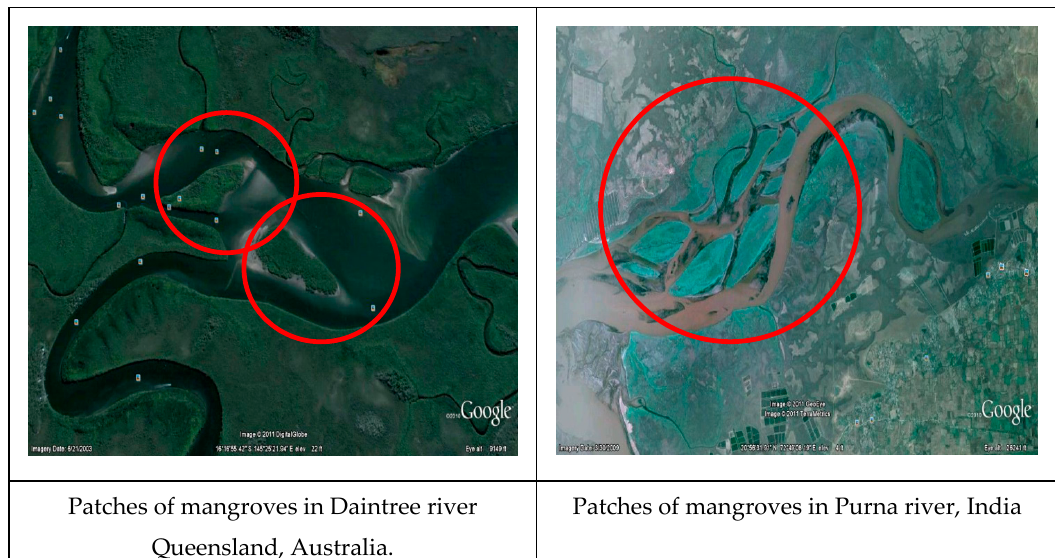
Figure 6. Patches of vegetation (highlighted in circles) present in the river systems (Background image is sourced from Google Earth).